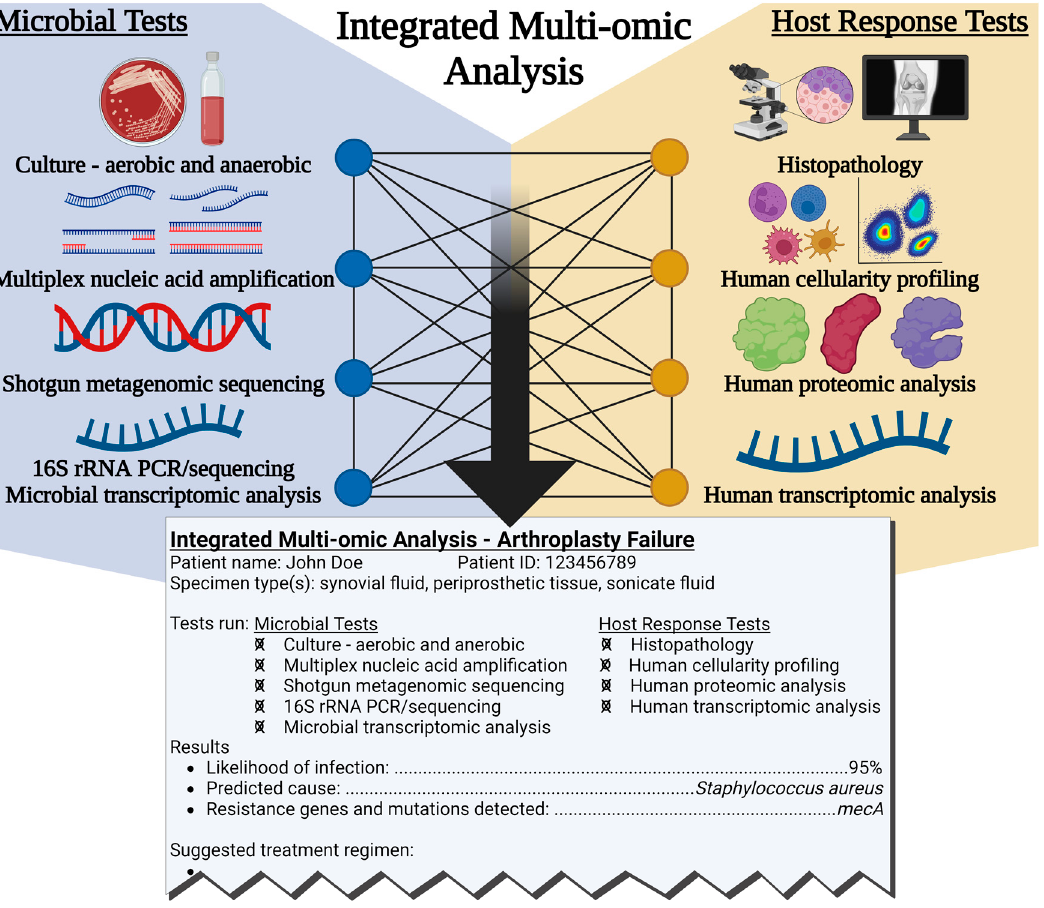
Figure 5. Potential multi-omics diagnostic scheme using simultaneous microorganism detection and assessment of host response to determine whether infection is present, and if so, to define the causative pathogen(s) and inform treatment. Created with Biorender.com.